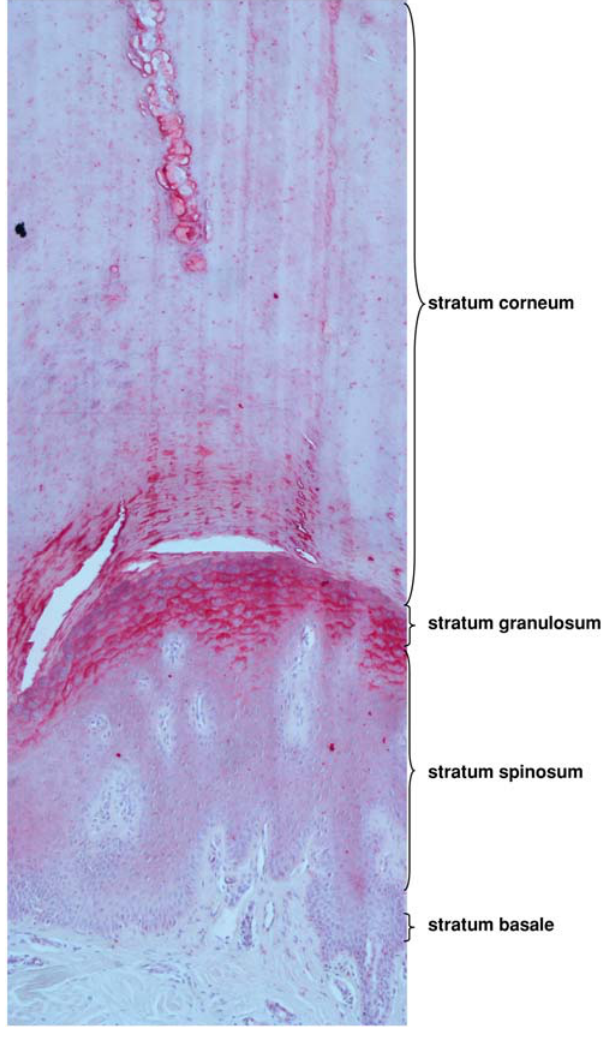
Figure 8. LEKTI-2 is highly expressed at sites of hyperkeratosis. Immunohistochemical staining (Vector red) of LEKTI-2 of a paraffin- embedded section of a clavus. Notice the enormously enlarged stratum corneum (hyperkeratosis) in the upper two third of the picture with a sweat gland sectioned at the upper first third. Clefts between the stratum corneum and the stratum granulosum are artefacts derived from histology processing. The upper part of the living epidermis, the stratum granulosum, exhibits a massive increase in LEKTI-2 immuno- reactivity (red). A representative result out of three different samples of clavi is shown.